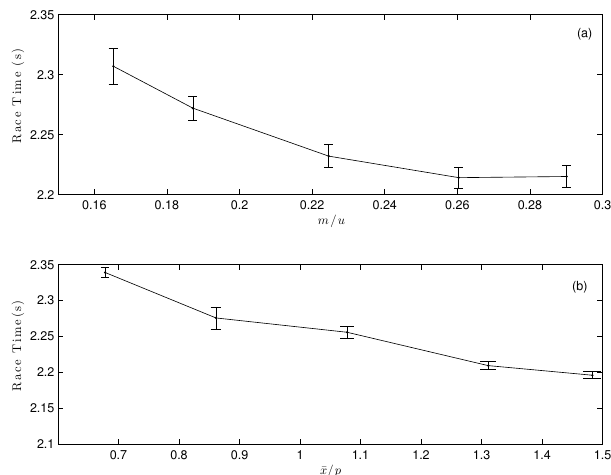
Figure 12. Experimental results of race times for cars with varying mass (a) and varying the horizontal center of mass (b) . The mass is normalized by the out-of-the-box car mass of u = 0 . 1091kg and ¯ x is normalized by the out-of-the-box center of mass p = 0 .